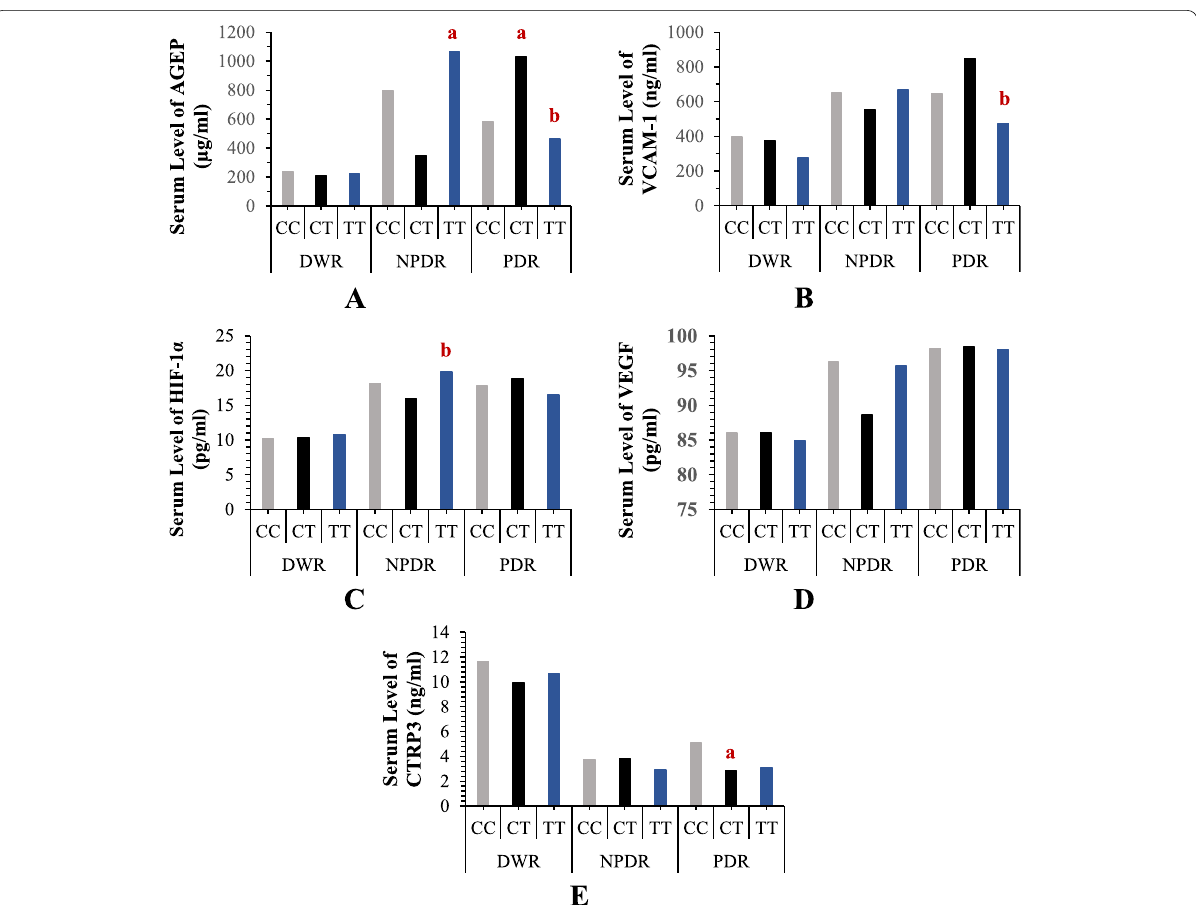
Fig. 2 The relationship of the serum levels of A AGEP, B VCAM, C HIF-1α, D VEGF, and E CTRP3 with the genotypes of HIF-1α rs11549465 in diabetic patients. Results are expressed as a median. a: significant compared to CC genotype while b: significant compared to CT genotype. P < 0.05 was considered